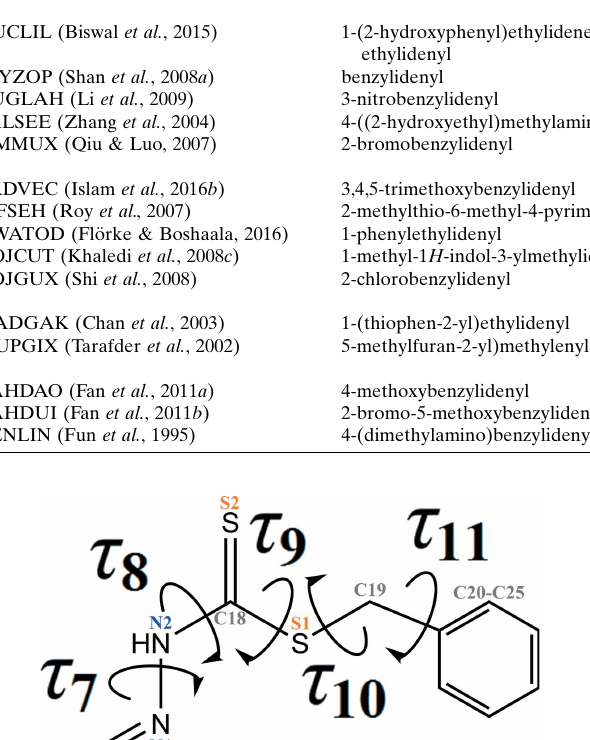
conformation (77.6–110.4 (cid:2) ). In most of the structures, the benzyl ring and the methylene sulfane moiety are orientated almost perpendicular to each other, as indicated by torsion angle (cid:3) . Here, either a syn -clinal (68.1–88.4 (cid:2) ) or an anti -clinal 11 (92.2–141.1 (cid:2) ) conformation is adopted. However, there is one outlier (WADGAK; Chan et al. , 2003) where the benzyl hydrazine-1-carbodithioate moiety is substituted with a 1-(thiophen-2-yl)ethylidenyl moiety. In contrast to most of the structures, torsion angle (cid:3) = 17.1 (cid:2) for WADGAK indicates a 11 syn -periplanar conformation.